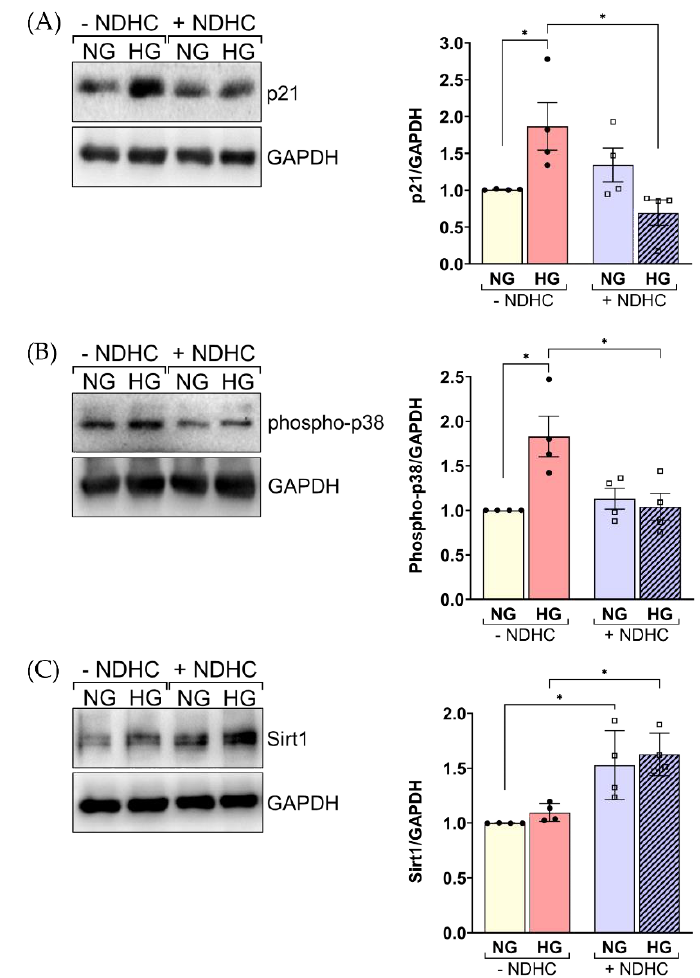
Figure 6. NDHD effects on senescence-related protein expression in HLE. HLE cells either pretreated with or without 10 µ M of NDHC before exposure to 5.5 mM (NG) or 55.5 mM (HG) glucose for 5 days. Cell lysates were separated by SDS-PAGE and Western blot was probed with ( A ) anti-p21, ( B ) anti-phospho-p38 and ( C ) anti-Sirt1 antibodies. The quantified signal intensities are presented as a ratio of the protein of choice to the corresponding GAPDH values normalized to the value of unstimulated LEC. Data are representative of three experiments (mean ± SD). * p < 0.05.